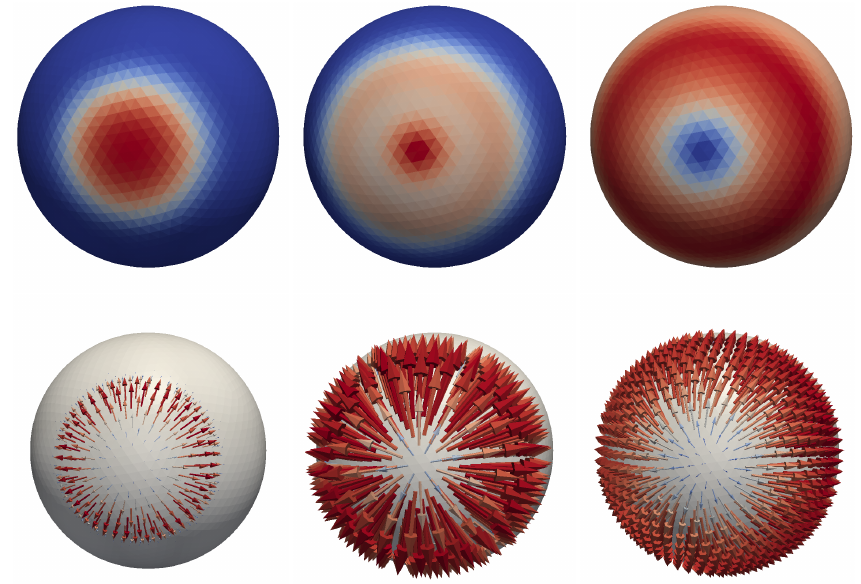
Fig. 9. Snapshots of the solution to the linear shallow water equations obtained using the method of Sect. 5.2, with V = RT 1 and Q = DG 0 . Top: D . Bottom: u .